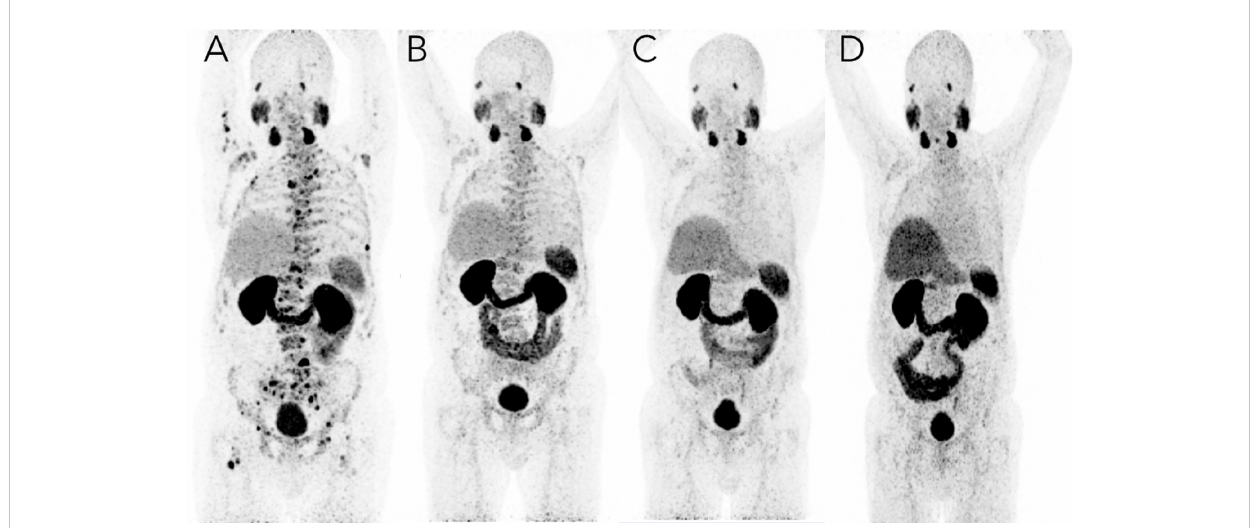
FIGURE 2 PSMA imaging before and after targeted radioligand therapy with 177 Lu – PSMA-617. A 73-year-old male with mCRPC in 2017 with multiple bone and lymph node metastases with increased PSMA expression. (A) Imaging on March 14, 2017, just before the fi rst dose of [ 177 Lu] – PSMA-617 therapy; the baseline coronal PET [ 68 Ga]-PSMA-11 PET maximum intensity projection (MIP) image shows bone metastases with signi fi cantly higher PSMA expression as well as the normal biodistribution of the tracer. (B) Imaging on July 24, 2017, just before the third dose of Lu-177 PSMA radioligand therapy, showed intense but decreasing uptake with an excellent target-to-background ratio, corresponding with molecular response to RLT therapy. Imaging four months (May 15, 2018) (C) and just over one year (February 11, 2019) (D) after the fourth dose of [ 177 Lu] – PSMA-617, the [ 68